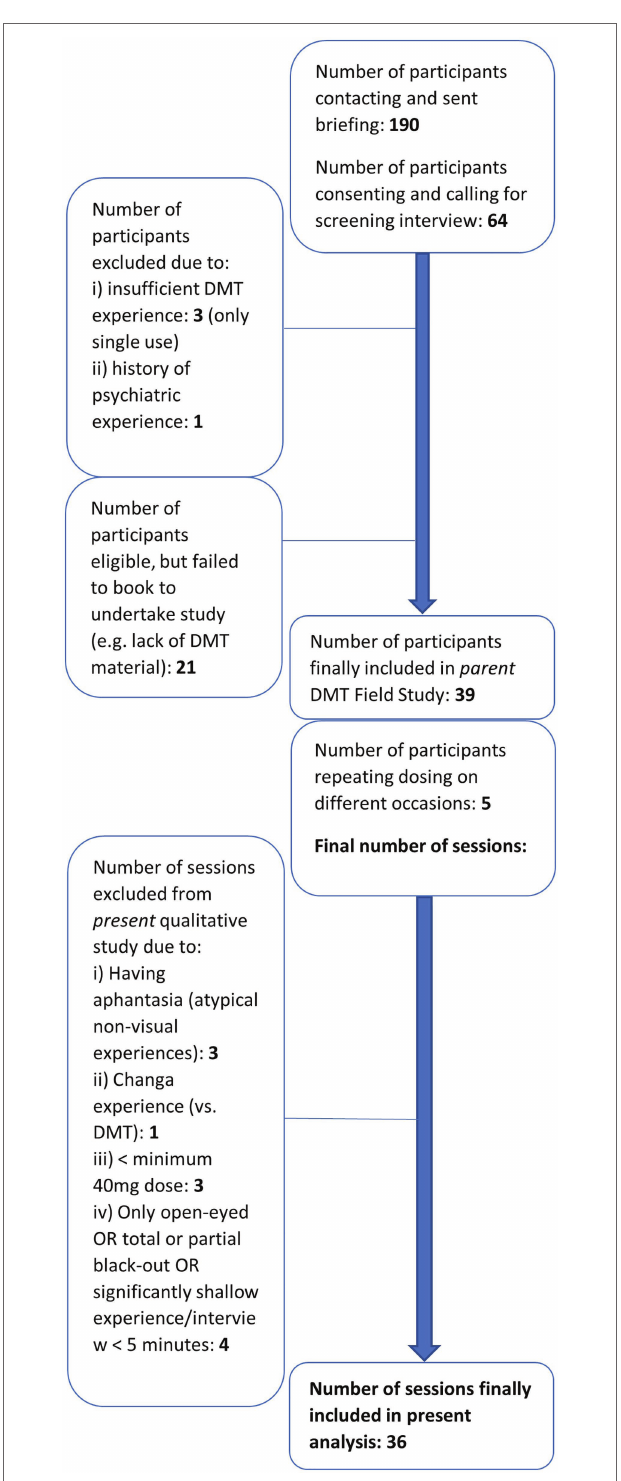
FIGURE 1 | Participant recruitment flowchart – inclusion, exclusion, and final sample size overall and of present